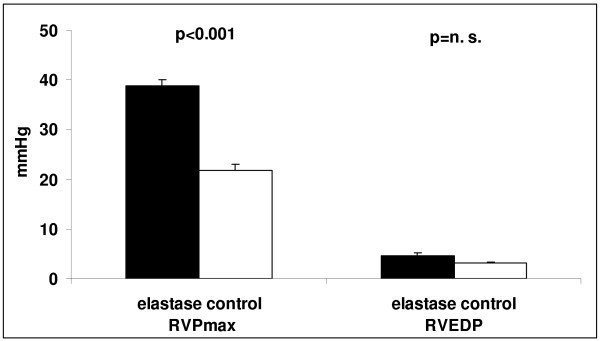
In vivo analysis of peak systolic RV pressure (RVP max) and RV end-diastolic pressure (RVEDP) of control and elastase treated (protocol 2) mice, indicating pulmonary hypertension of emphysematous mice.